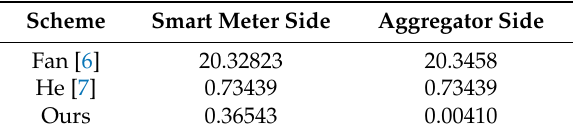
Table 11. Computation cost of registration phase in milliseconds.